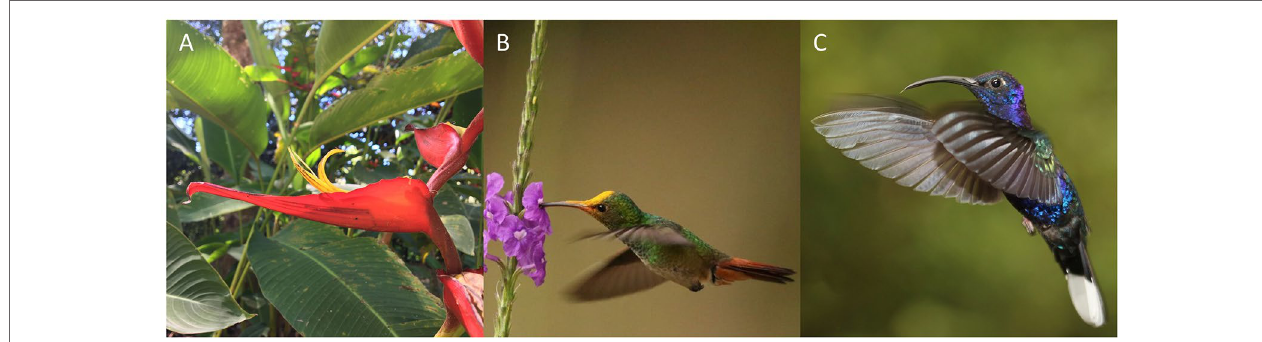
FiGUrE 1 | (a) Inflorescence of Heliconia tortuosa . Focus on a single red bract subtending a curved and tubular yellow flower. (B) A territorial rufous tailed hummingbird ( Amazilia tzacatl ). (c) A traplining violet sabrewing hummingbird ( Campylopterus hemileucurus ). Photo credits: Felipe Torres-Vanegas (a) , Matthew G. Betts (B) , and Urs G. Kormann (c)